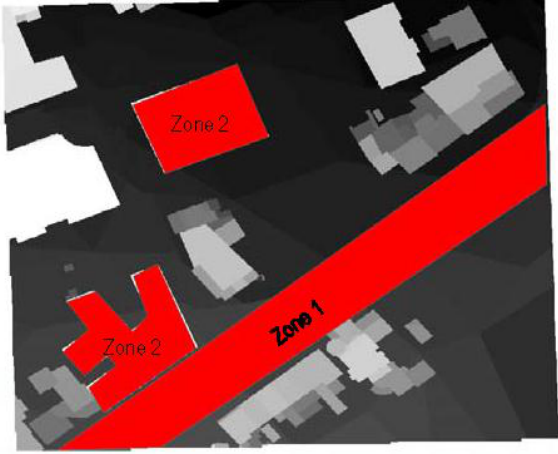
Figure 14. Illegal zones of sensor deployment: the street (Zone 1) and the buildings (Zone